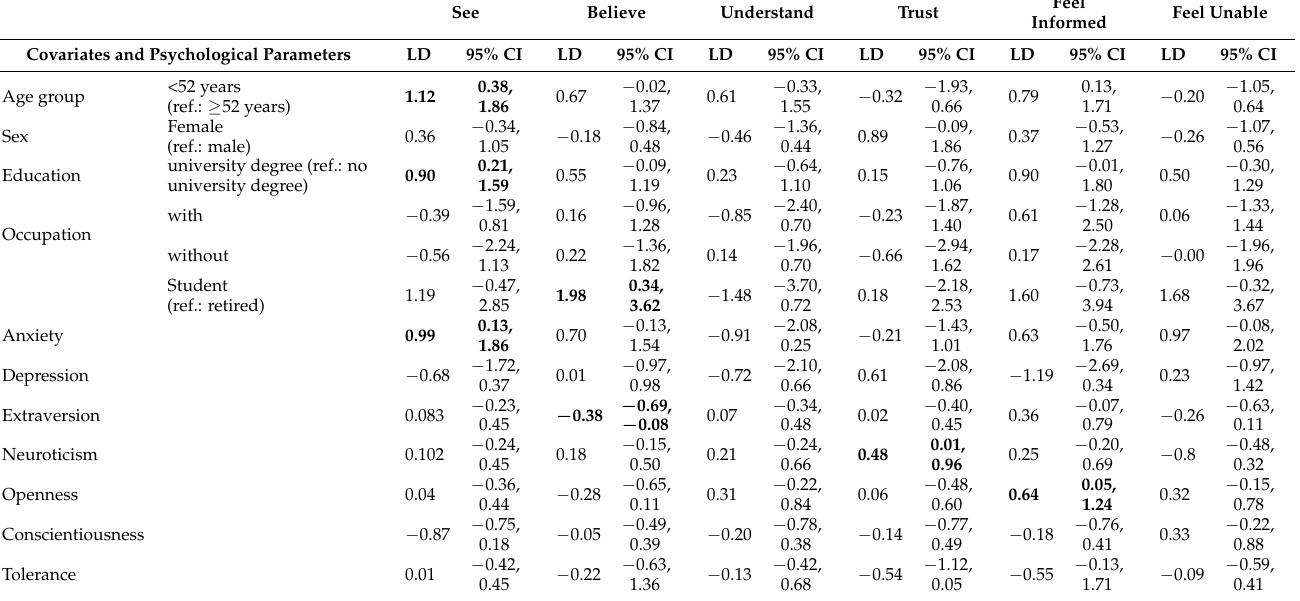
Table 3. Results of the logistic ordinal regression. We assessed how different covariates (age, sex, education, occupation) and psychological parameters (PHQ-4: Anxiety and Depression; BFI-10: extraversion, neuroticism, openness, conscientiousness, and tolerance as BFI-Score = BFI-S) were associated with the difference between AI-based and conventional communication on patients seeing, believing, understanding, trusting, and feeling towards the radiographic diagnosis of a caries lesion (see Figure 2). The regression analysis indicates how the covariates and the parameters modified the possible increases or decreases in these outcomes when using AI-based instead of conventional communication; the measure of this modification is the expressed as scale difference (LD) and 95% confidence intervals (CI). Bold values indicate statistical significance ( p < 0.05). (ref. = reference). See Believe